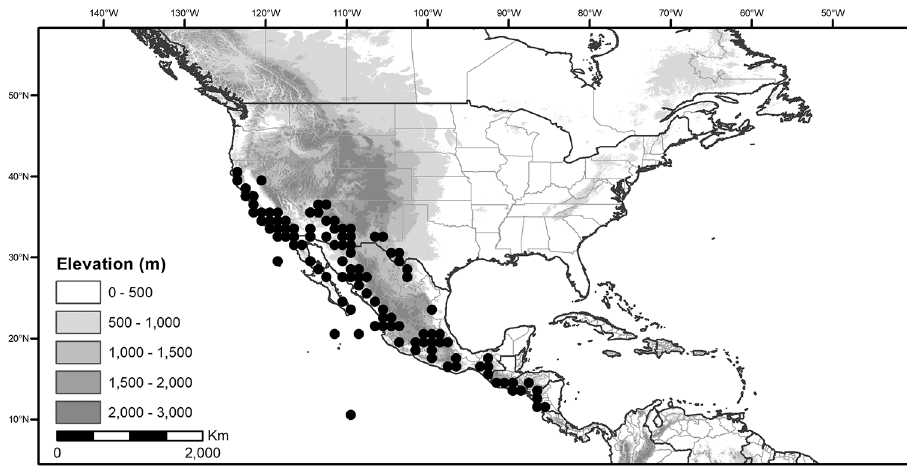
Figure 14. Distribution of Solanum douglasii Dunal